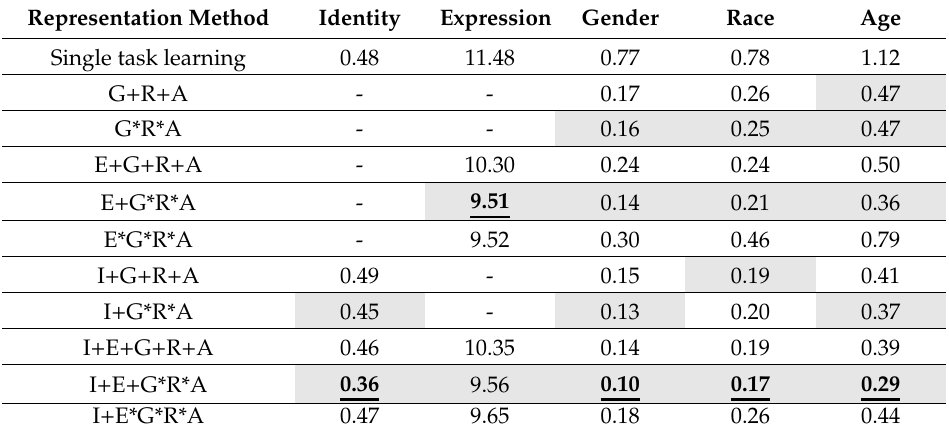
Table 2. Recognition error (%) of five facial attributes under di ff erent representation methods. Representation